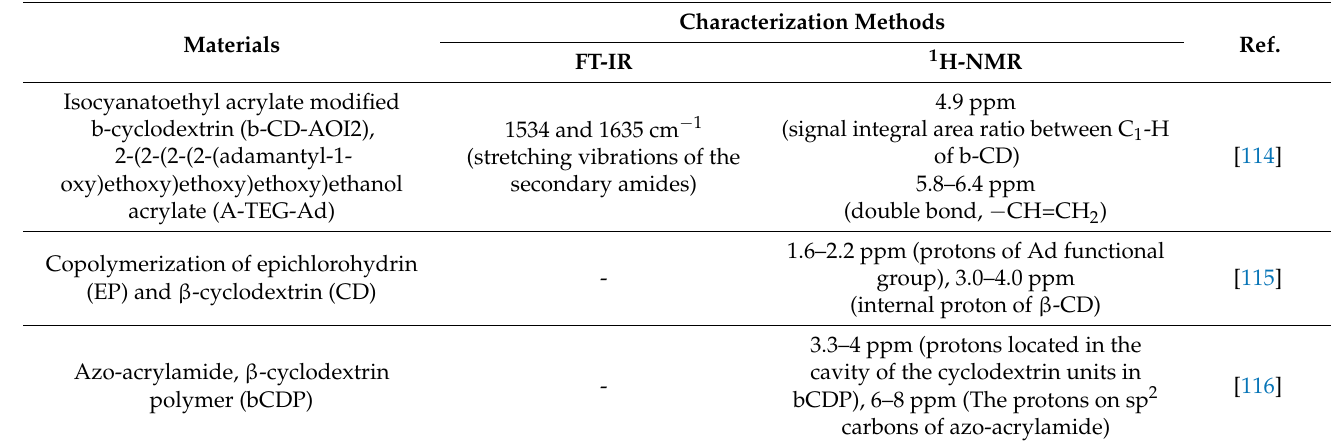
Table 7. Overview of characterization methods for host–guest